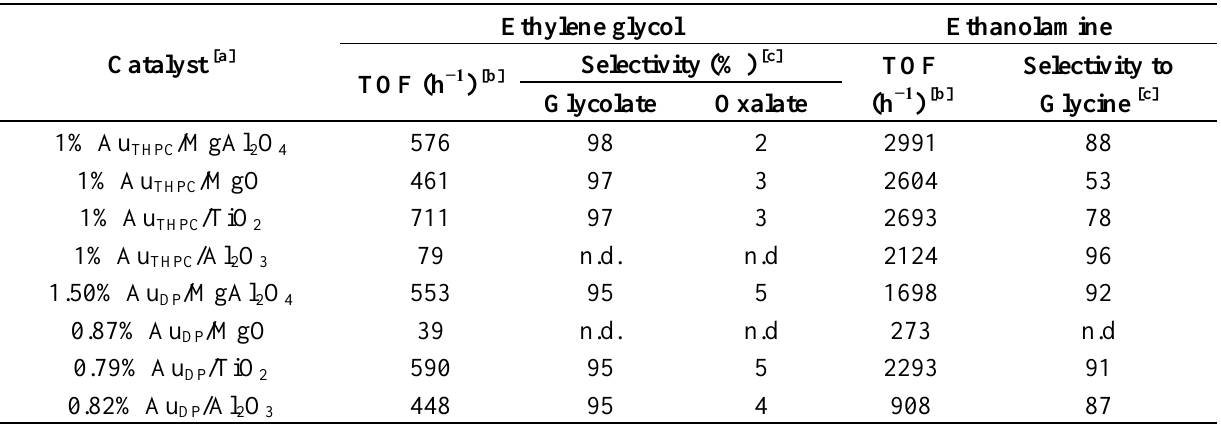
Table 3. Comparison of Au catalyst activities in ethylene glycol and Ethanolamine oxidation.